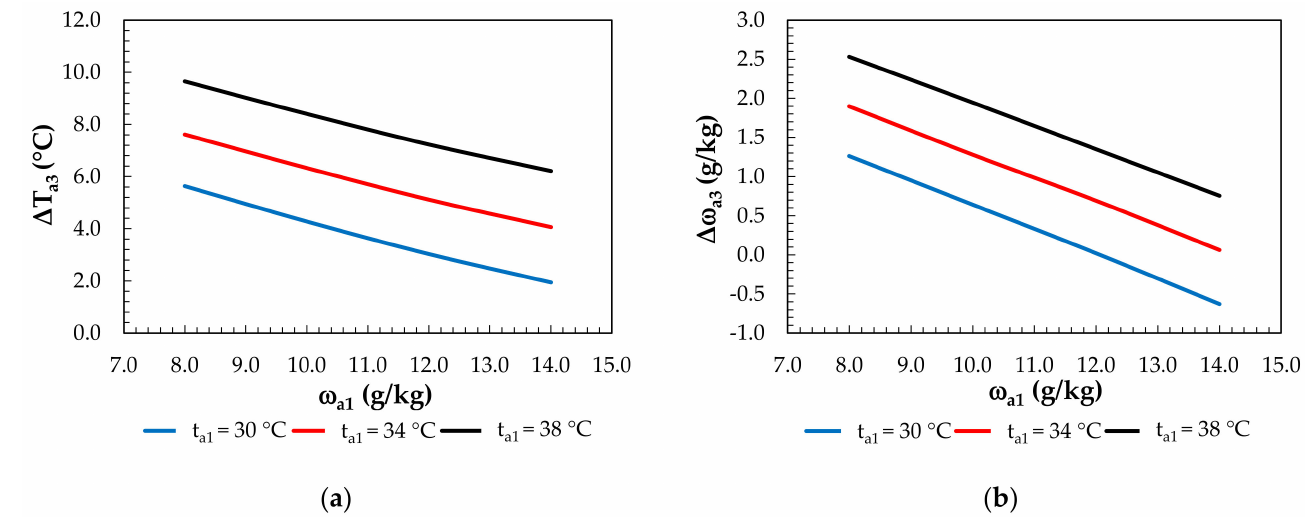
Figure 12. Effect of the inlet air humidity ratio for constant inlet air temperatures under mixing: ( a ) on air temperature differences; ( b ) on the change in the humidity ratio.